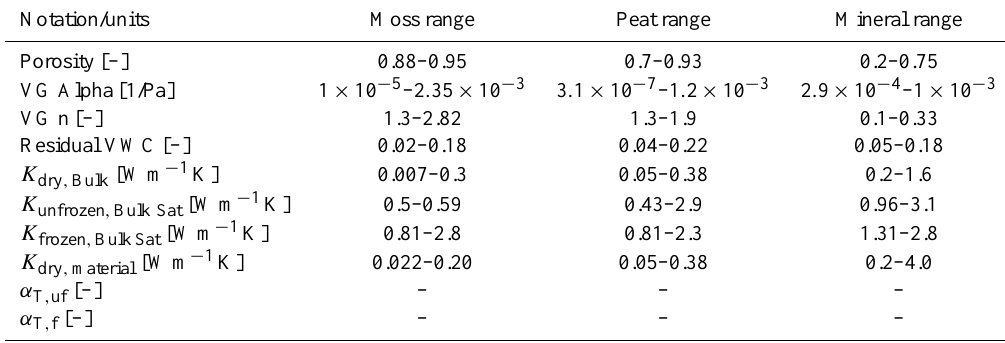
Table 1. Valid parameter range for calibration sets.